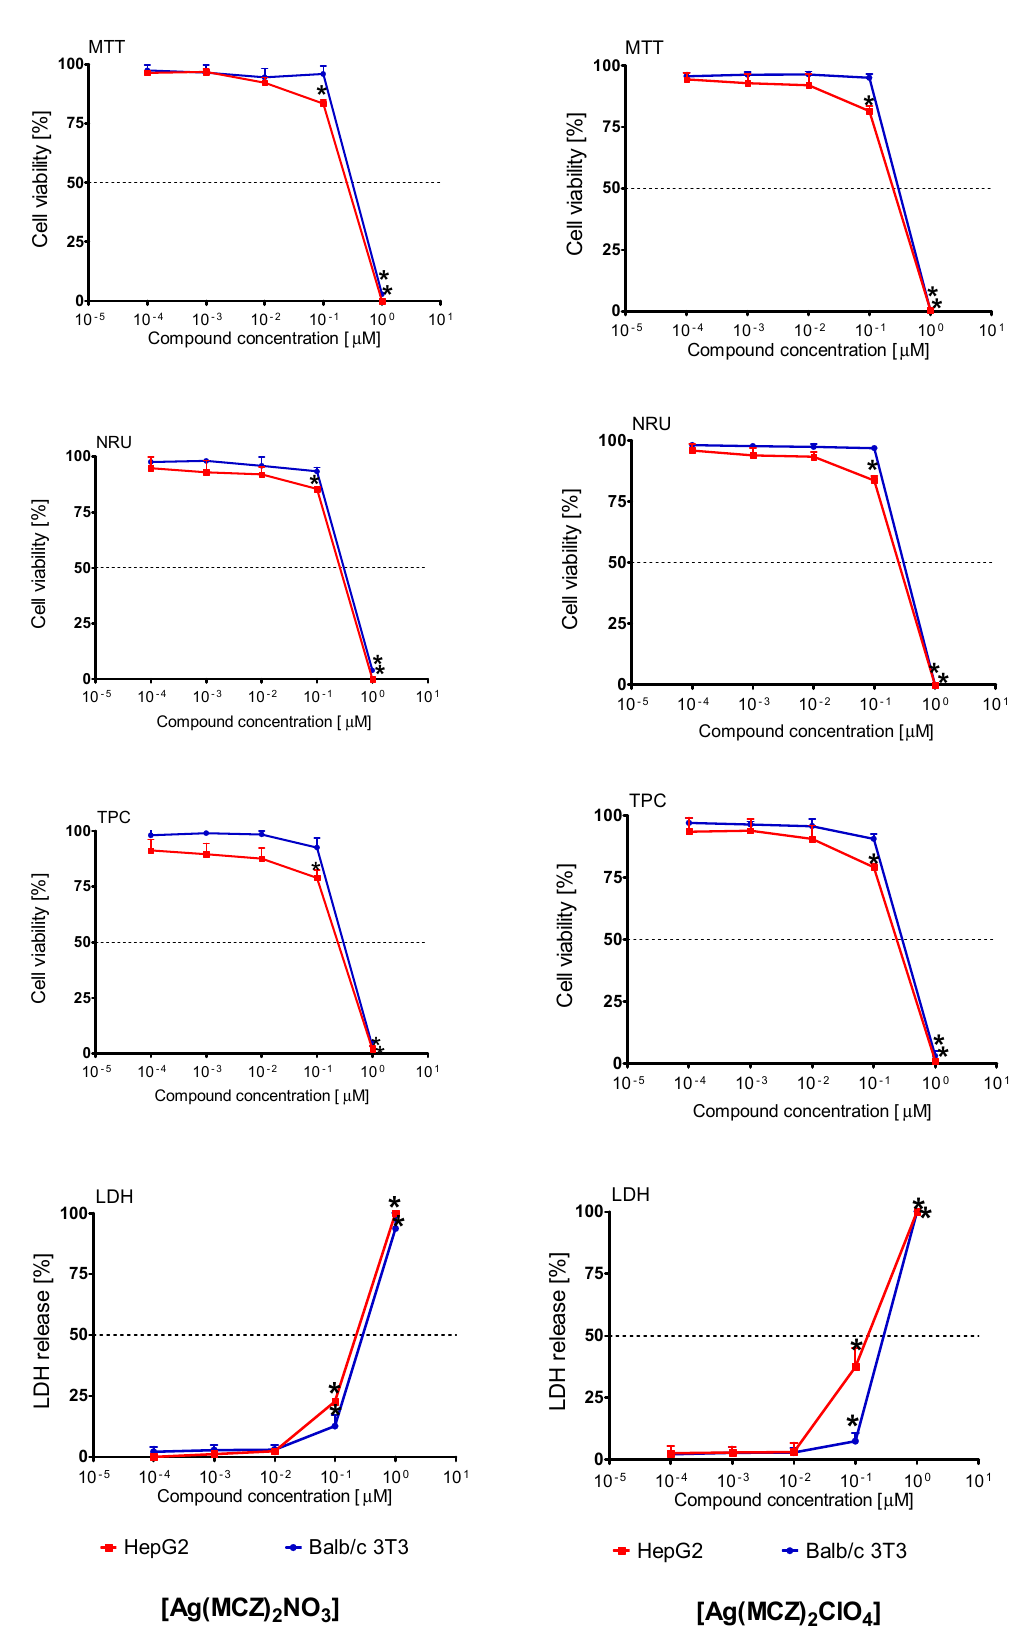
Figure 5. Concentration-dependent response curves for the studied compounds for HepG2 cells and Balb / c 3T3 fibroblasts measured by MTT, NRU, TPC, and LDH assays. The data are presented as means ( n = 3) ± SD (* p ≤